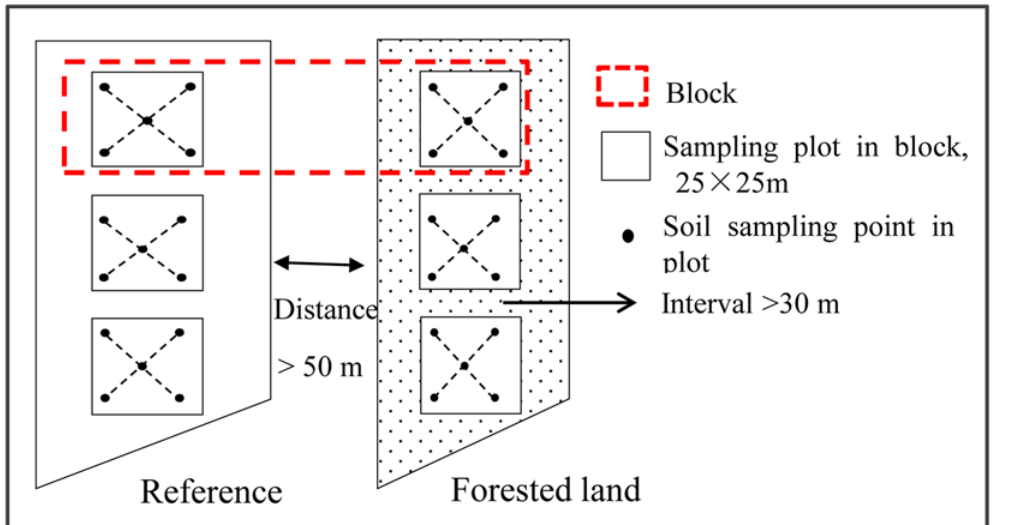
Fig 2. Scale map of soil sampling locations at one site on the Qinghai